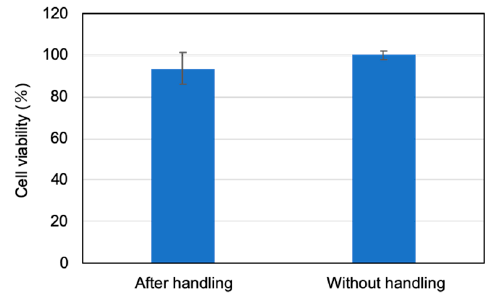
Figure 10. Experimental results of lactate dehydrogenase (LDH) cytotoxicity evaluation.